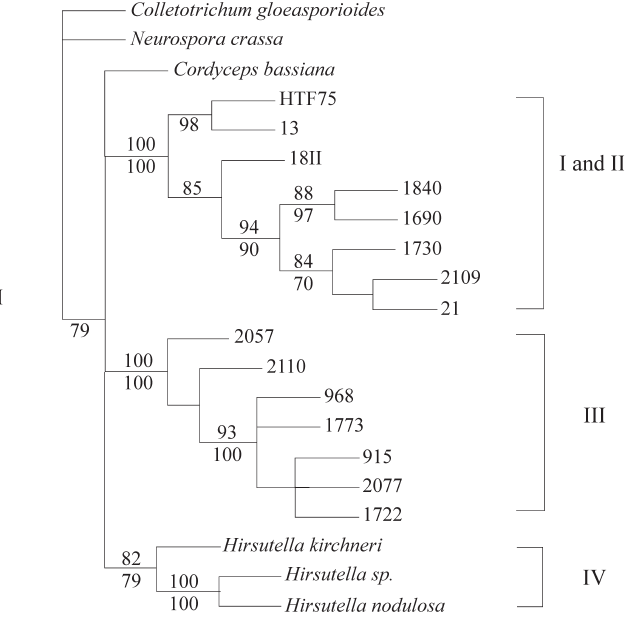
Figure 3 - Maximum parsimony (MP) tree based on (cid:2) -tubulin sequences. This tree also represents the topology obtained with the neighbor joining (NJ) analysis. Numbers next to the branches are bootstrap percentage val- ues, based on 1,000 replicates and obtained with MP (above) and NJ (be- low) analyses. The outgroups are Neurospora crassa and Colletotrichum gloeosporioide .